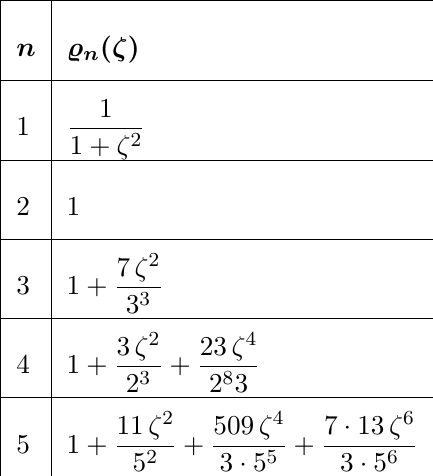
Table 3 . The functions % n ( (cid:16) ) appearing in the Coulomb limit of the cross-sections for the radiative formation of zero angular momentum states of principal quantum number n , (i) with emission of a vector force mediator [cf. eq. (3.8c)], and (ii) with emission of a scalar mediator, by particles of di(cid:11)erent species [cf. eq.